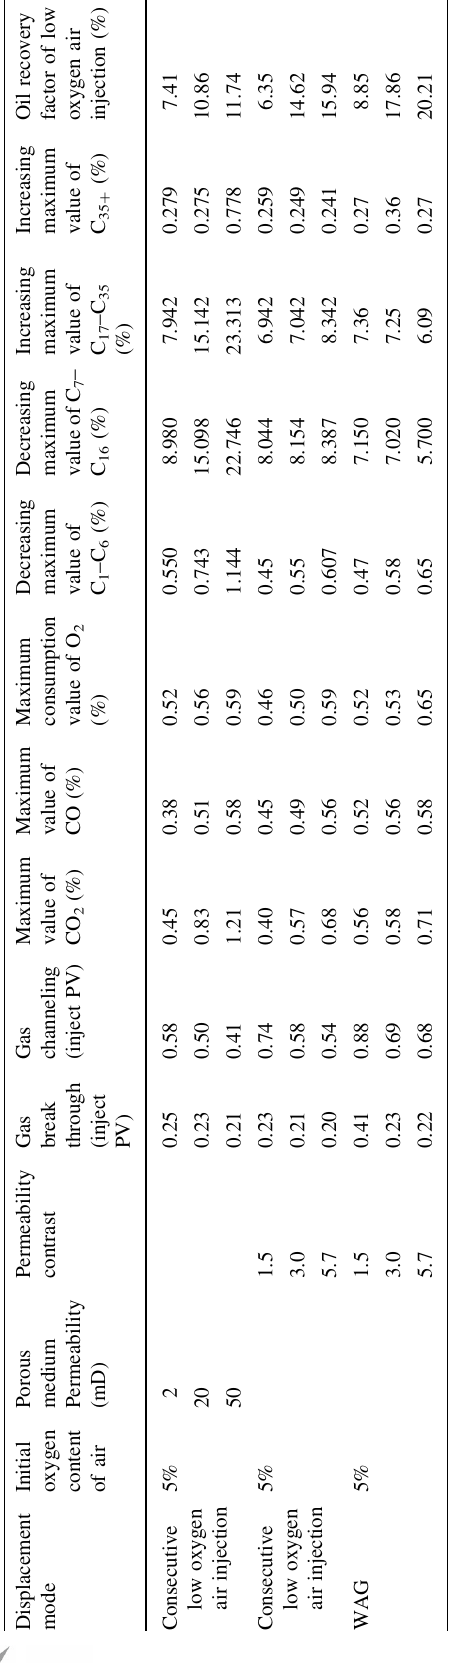
Fig. 4 Photography of long core after flooding experiment